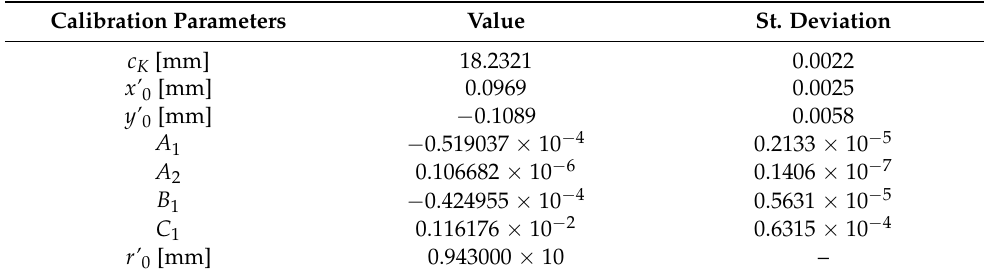
Table 2. Calibration parameters of the DSLR Nikon D5100 camera. Calibration Parameters